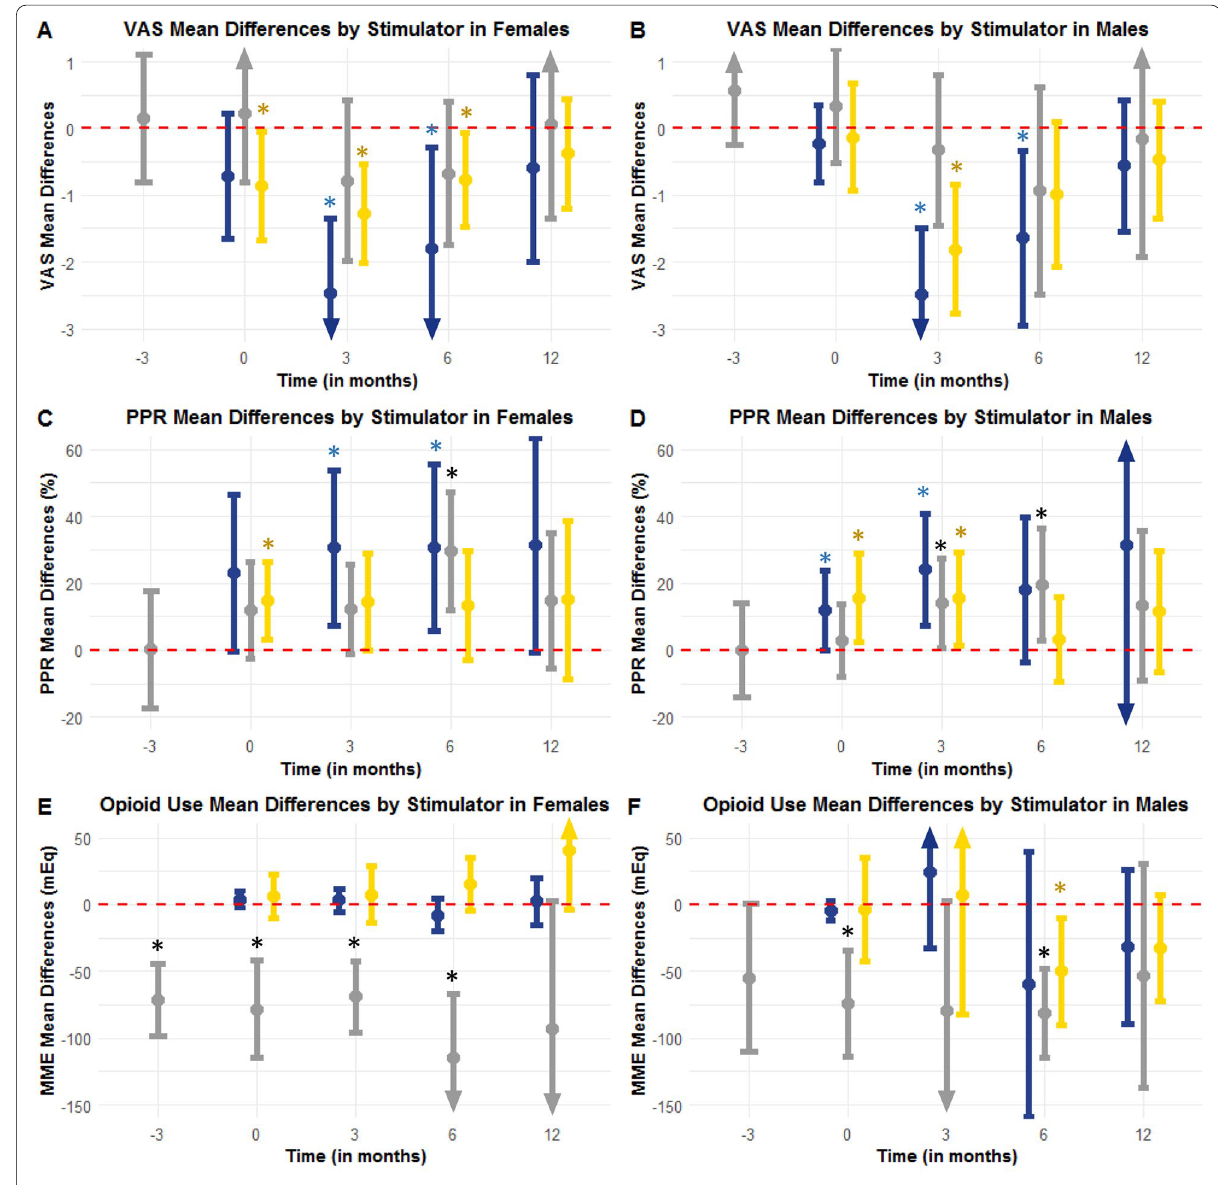
Fig. 3 Visual Analog Scale Pain Scores, Perceived Pain Reduction and Morphine Equivalent Daily Dose based on Type of Spinal Cord Stimulator and Sex. Blue stars note significant difference for HF-SCS at that time point compared to baseline. Yellow stars note significant differences for LF-SCS at that time point compared to baseline. Black stars note significant differences between HF-SCS and LF-SCS at that time point. Confidence intervals which cross the dotted red line are considered nonsignificant. Arrows denote continuation of confidence interval out of graph limits. a Visual analog scale pain score distribution by type of stimulator at baseline, post-implantation, 3 months after implant, 6 months after implant and 12 months after implant in females. b Visual analog scale pain score distribution by type of stimulator at baseline, post-implantation, 3 months after implant, 6 months after implant and 12 months after implant in males. c Perceived pain reduction distribution by type of stimulator at baseline, post-implantation, 3 months after implant, 6 months after implant and 12 months after implant in females. d Perceived pain reduction distribution by type of stimulator at baseline, post-implantation, 3 months after implant, 6 months after implant and 12 months after implant in males. e Opioid use in morphine miliequivalents by type of stimulator at baseline, post-implantation, 3 months after implant, 6 months after implant and 12 months after implant in females. f Opioid use in morphine miliequivalents by type of stimulator at baseline, post-implantation, 3 months after implant, 6 months after implant and 12 months after implant in